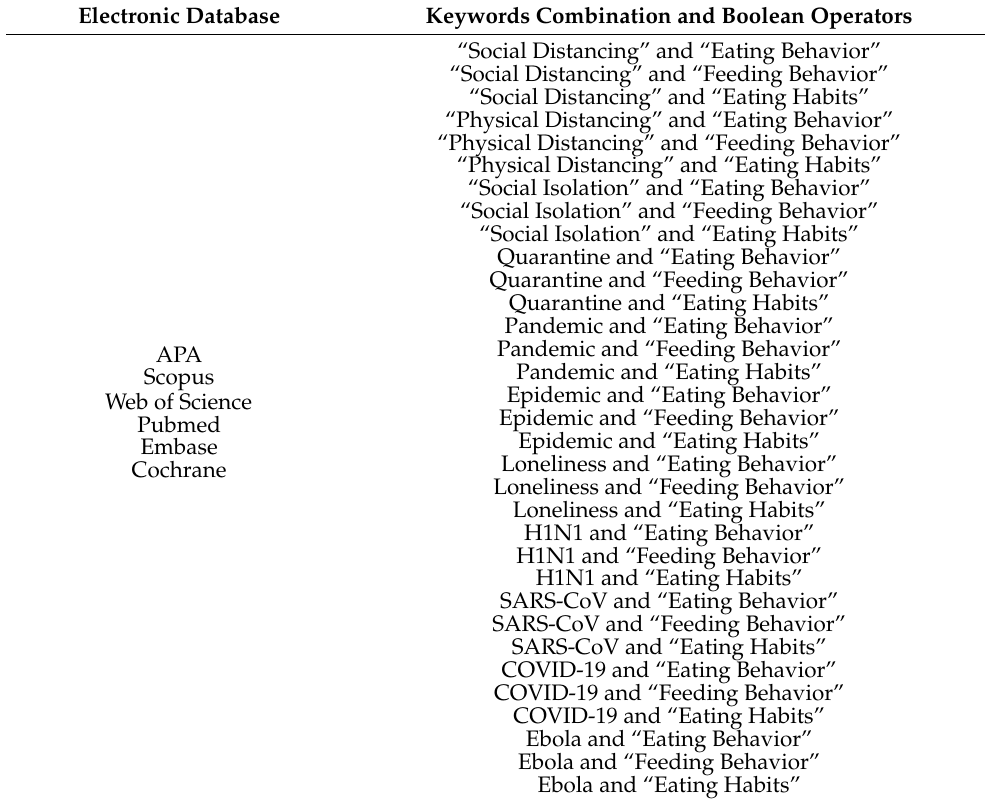
Table A1. Electronic databases, keywords combination and Boolean operators used in the study search